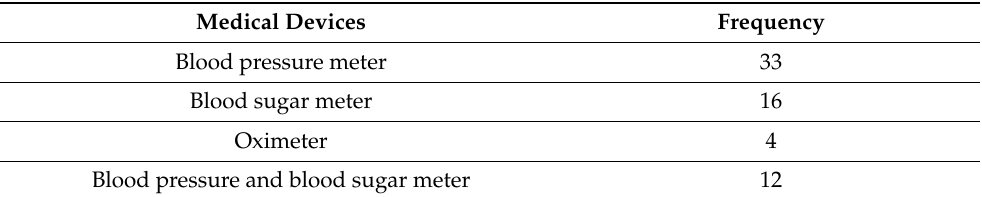
Table 3. Types of medical devices used at home (select multiple options allowed).